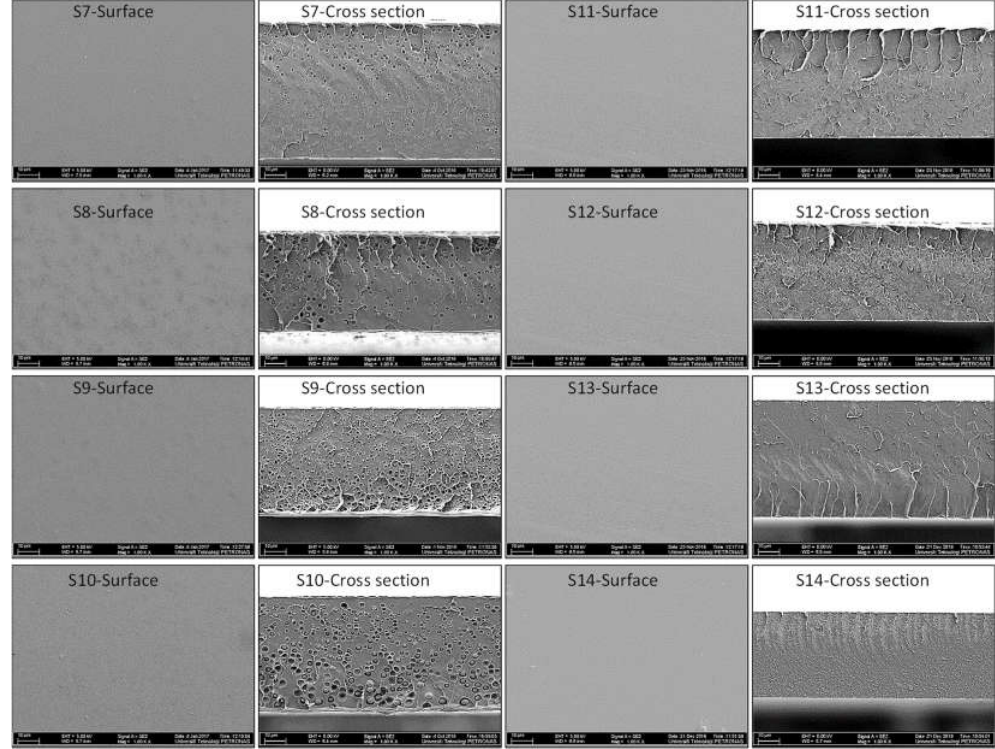
Figure 1. FESEM images of MMMs at 1000×.